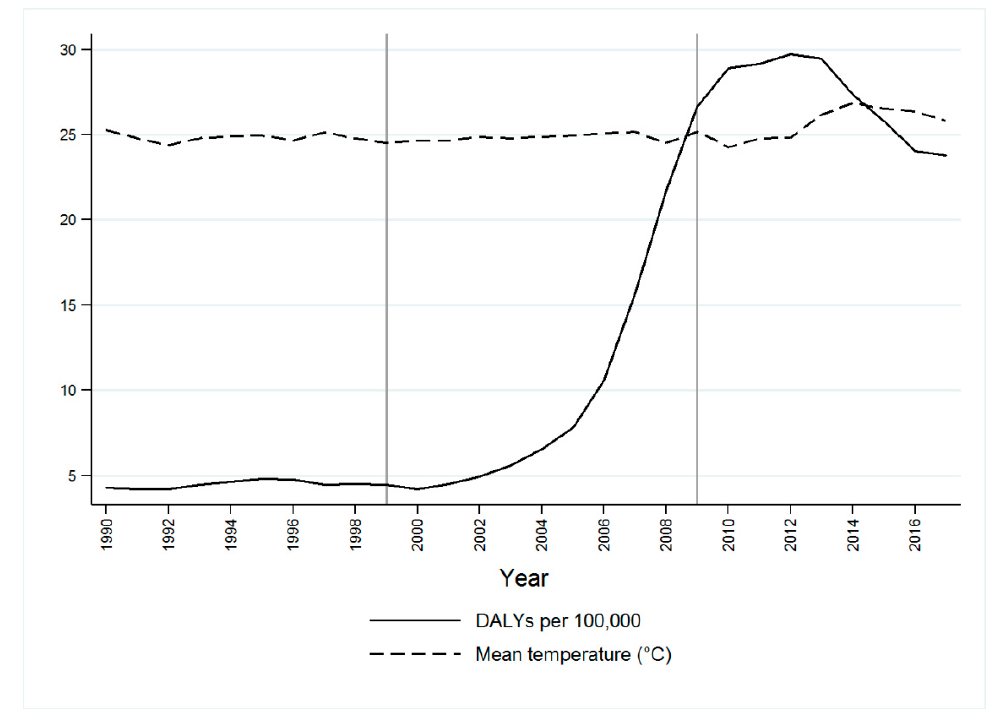
Figure 4. Disability-adjusted life years (DALYs) due to dengue among school-aged children and mean temperatures (°C) in urban areas from Colima, Mexico, 1990–2017.